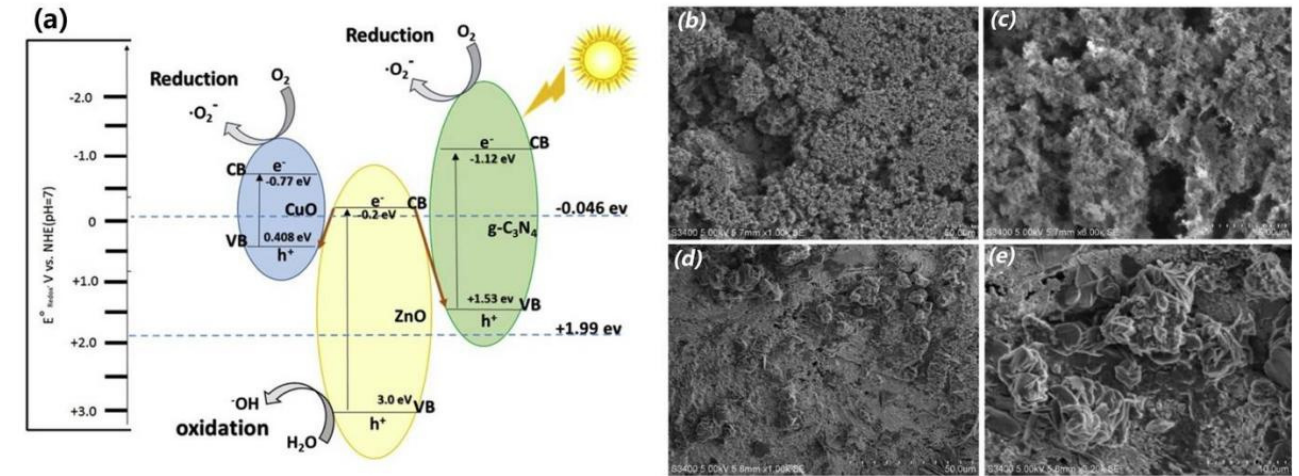
Figure 8. ( a ) Schematic diagram of the charge migration pathway in CuO/ZnO/g-C 3 N 4 ; SEM images of ( b , c ) CuO/ZnO and ( d , e ) CuO/ZnO/g-C 3 N 4 with different magnifications. Used with permission from [135]. Copyright 2019 Elsevier.